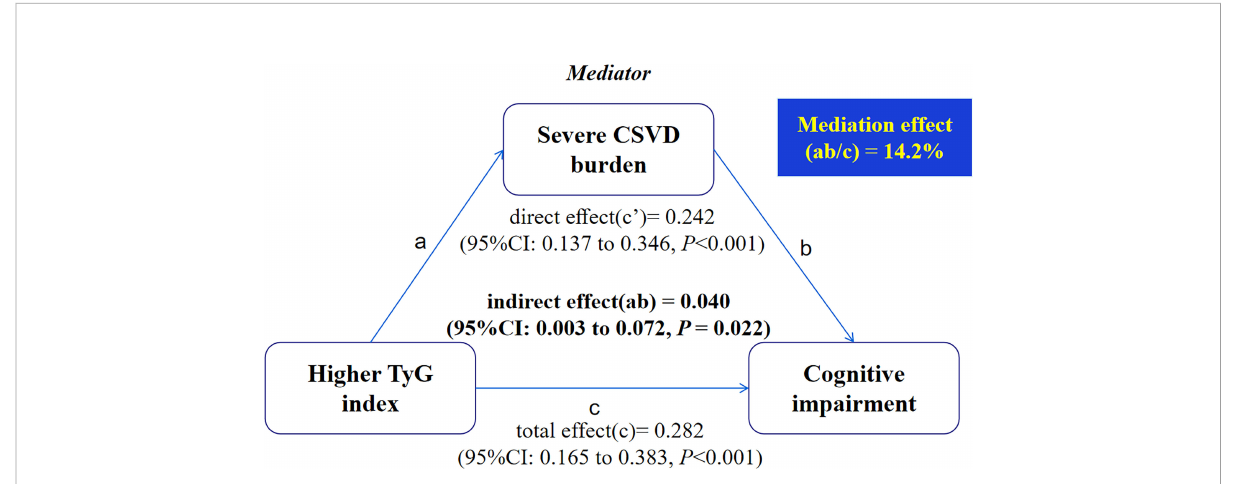
FIGURE 2 Mediation analysis is shown for the presence of severe CSVD burden as a mediator in the relation between higher TyG index and cognitive